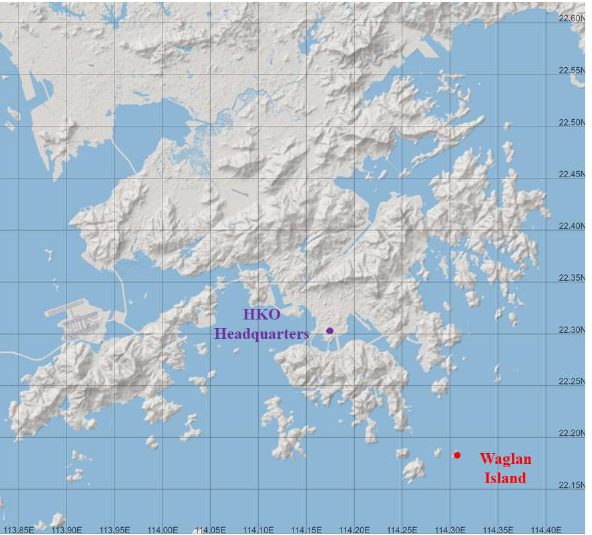
Figure 4. The location of HKO Headquarters (purple) and Waglan Island (red). (Background topography: Open Street Map, openstreetmap.org).